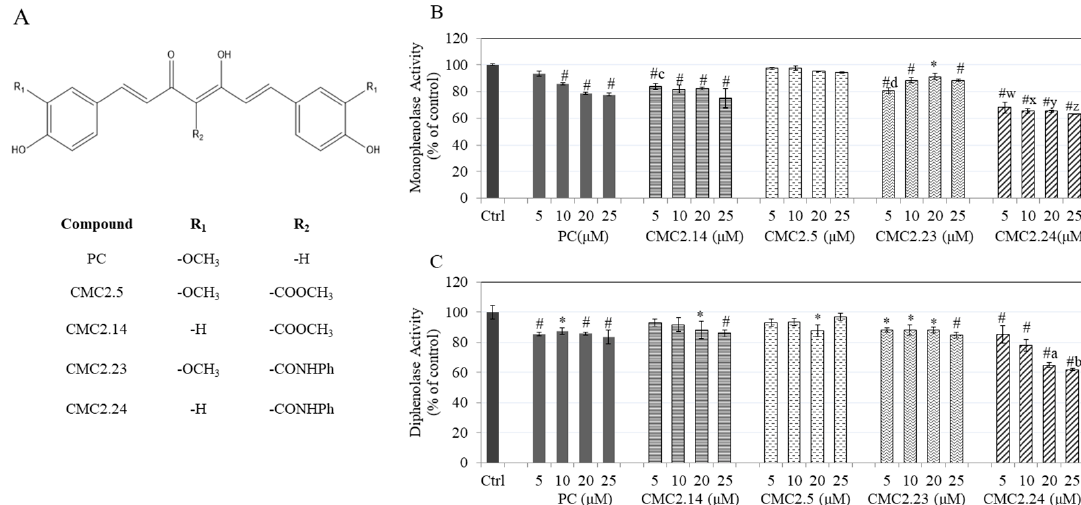
Figure 1. ( A ) Chemical structures of compounds obtained from modifications of the parent structure of curcumin. R 1 denotes group modification of the two phenyl rings (-OCH 3 /-H) and R 2 denotes group modification of the β -diketone moiety (-CONHPh/-COOCH 3 ); Effect of the compounds on ( B ) Monophenolase activity and; ( C ) Diphenolase activity of mushroom tyrosinase; Data are mean ± SD of triplicates; * p < 0.01 and # p < 0.001 vs. Ctrl, letter c— p < 0.001 vs. PC (5 µ M) and letter d— p < 0.001 vs. PC (5 µ M); Letters-w, x, y, z all p < 0.001 vs. PC at 5, 10, 20, 25 µ M, respectively; letter a— p < 0.001 vs. PC (20 µ M) and letter b— p < 0.001 vs. PC at 25 µ M; One-way ANOVA followed by Tukey’s test.